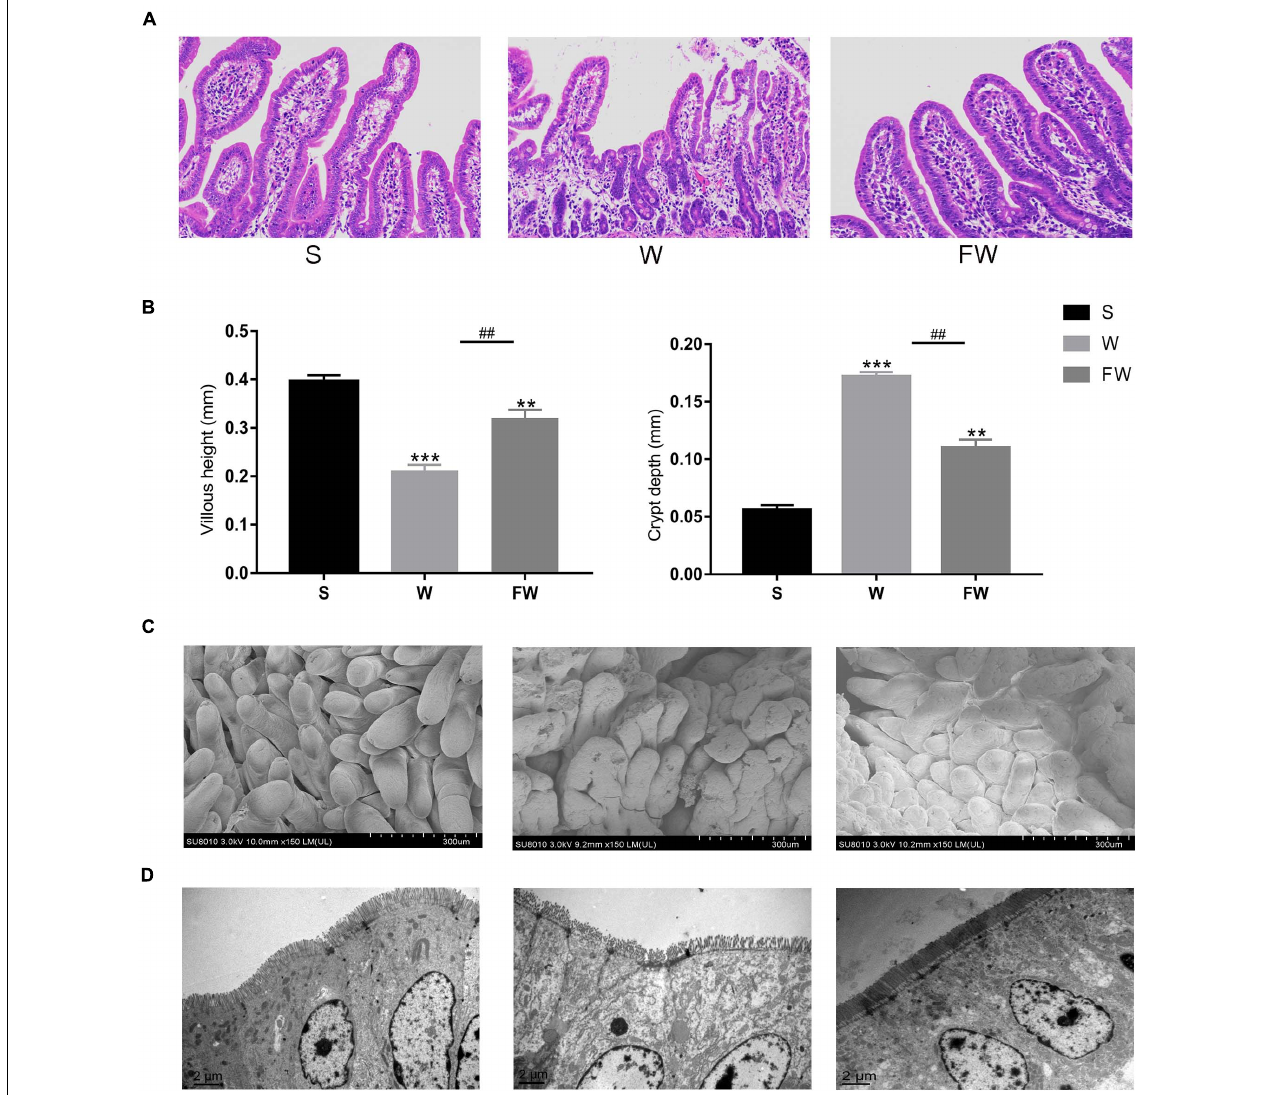
FIGURE 6 | Jejunum sections were used to analyze intestinal morphology. (A) Stained with H&E (bars, 200 µ m). (B) The villus height (mm) and crypt depth (mm) were measured. Data were represented as mean ± SEM for the three different experiments (* p < 0.05, ** p < 0.01, *** p < 0.001, # p < 0.05, ## p < 0.01, and ### p < 0.001). (C) SEM images (150 × ). (D) TEM images (8,000 × ). (S, Sucking; W, Weaned; FW,